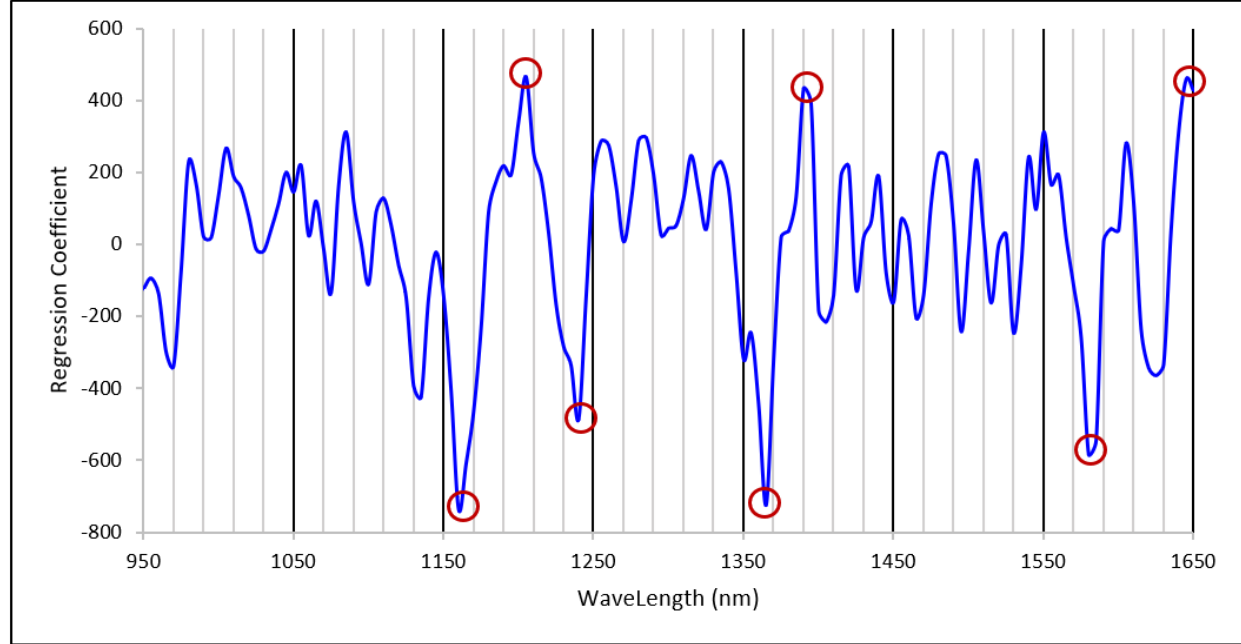
Figure 4. Regression coefficient plot of the 11 PLS factor starch calibration with important regression peaks marked.